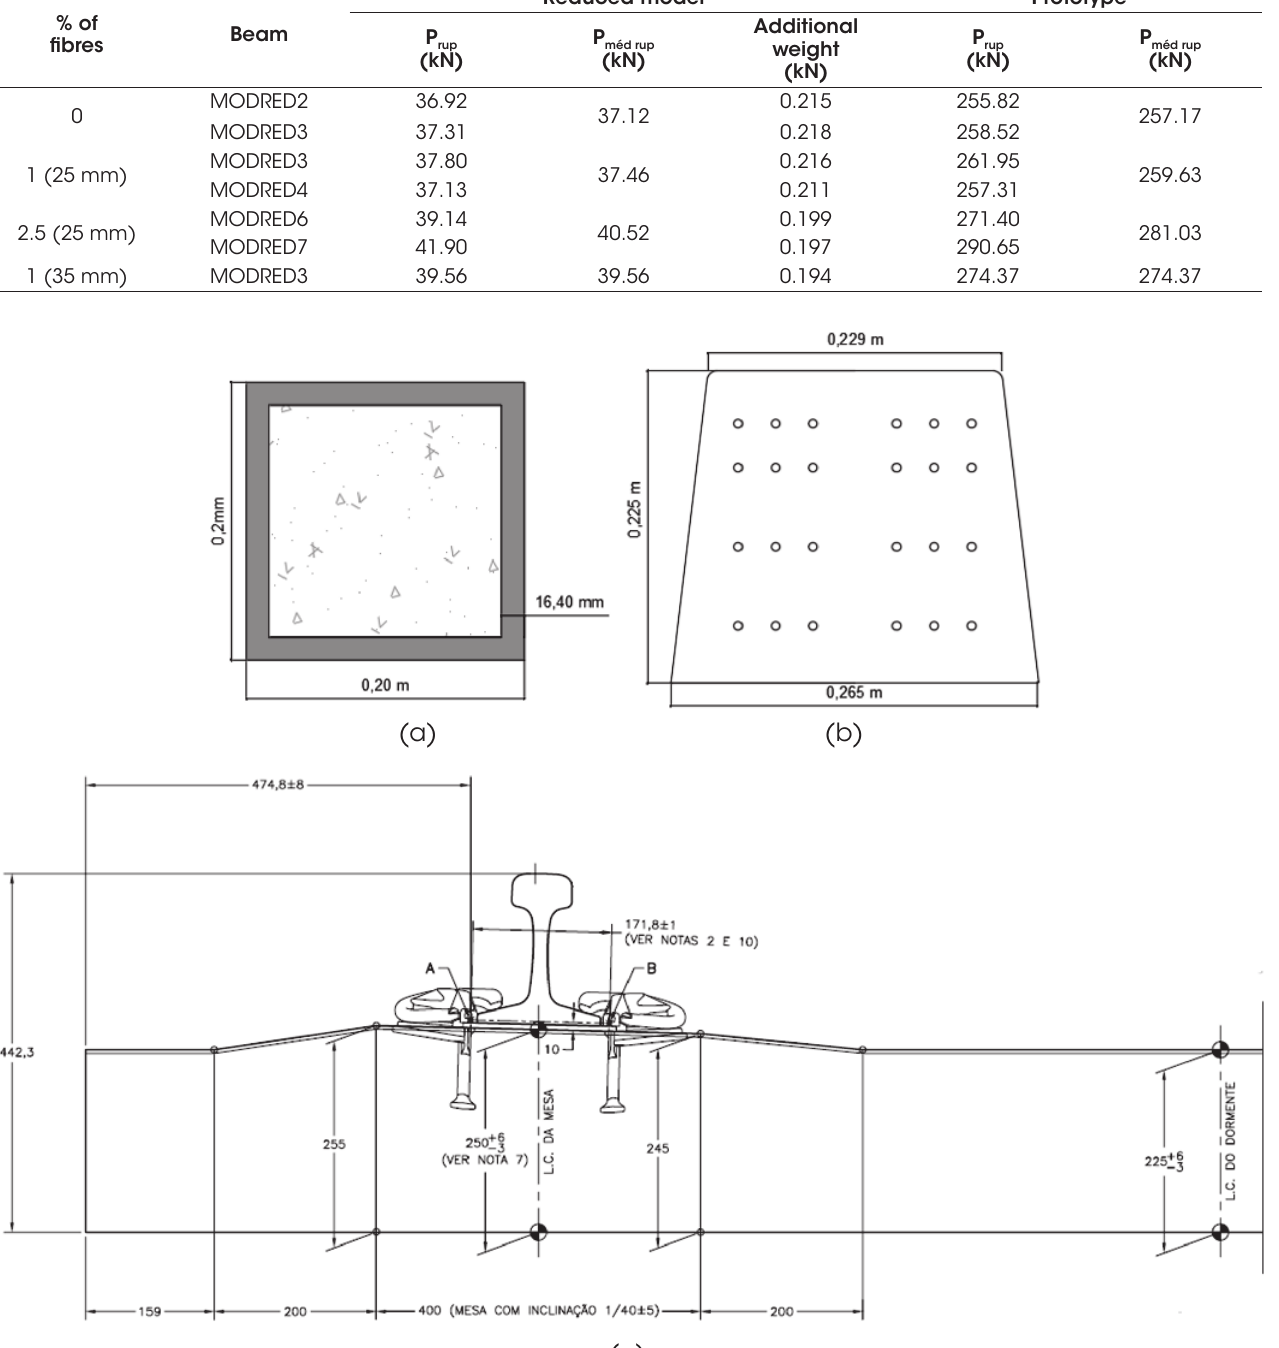
Additional load and failure load on the sleeper reduced models and prototypes (loading in the center of the sleeper) % of